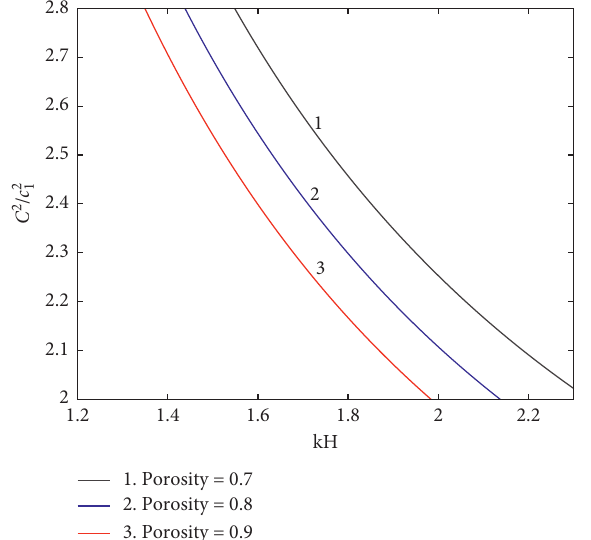
Figure 7: Model-II: effect of the irregularity parameters ( x / H ) and ( bH ) under soft mountain surface.